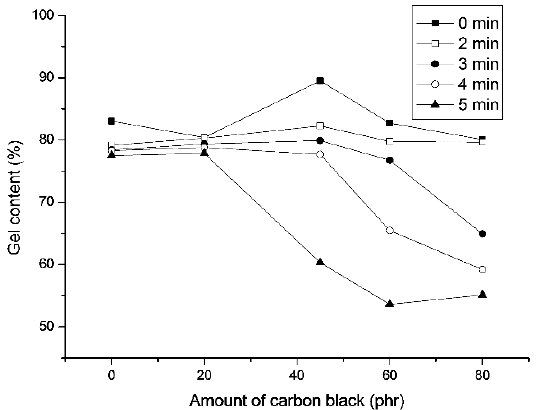
Figure 3. Gel content versus amount of carbon black of the samples after different times of exposure to microwaves.